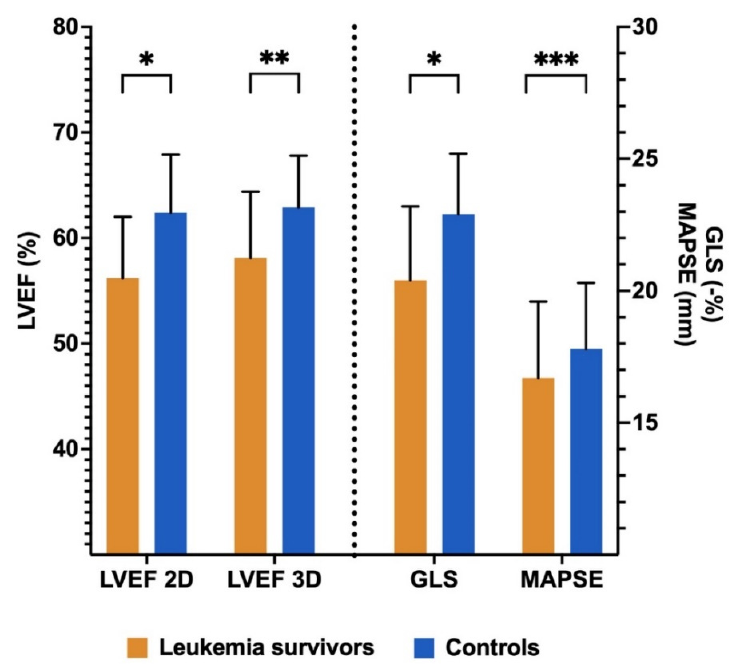
Figure 3. Left ventricular systolic function parameters in leukemia survivors and controls. LVEF, left ventricular ejection fraction; GLS, global longitudinal strain; MAPSE, mitral annular plane systolic excursion, average of septum, and lateral. * p < 0.001, ** p < 0.01, *** p < 0.05.